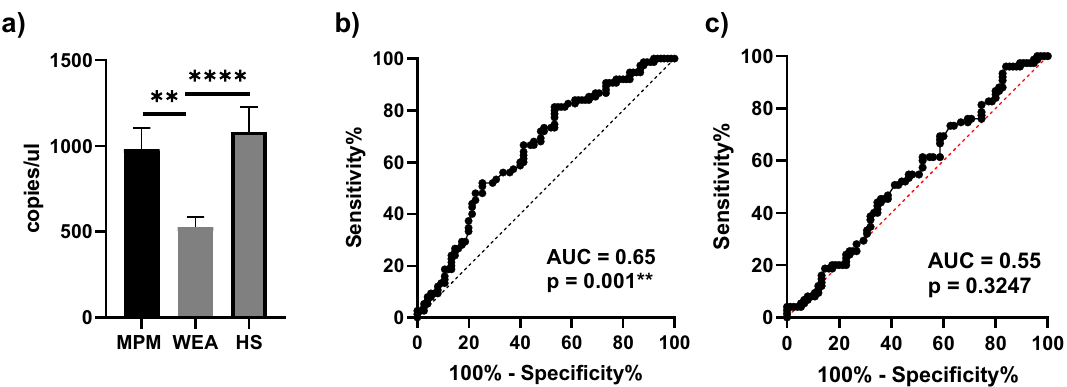
Figure 1. MiR-197-3p analysis by ddPCR. ( A ) WEA and HS cohorts: the amount of miR-197-3p is represented as copies/µl of analyzed cDNA (ANOVA **** P < 0.0001; Tukey’s test: MPM vs WEA ** P = 0.0036; WEA vs HS **** P = 0.0001); ( B ) ROC curve for the comparative analysis of miR-197-3p levels in MPM vs. WEA; ( C ) ROC curve for the comparative analysis of miR-197-3p levels in MPM vs. HS.